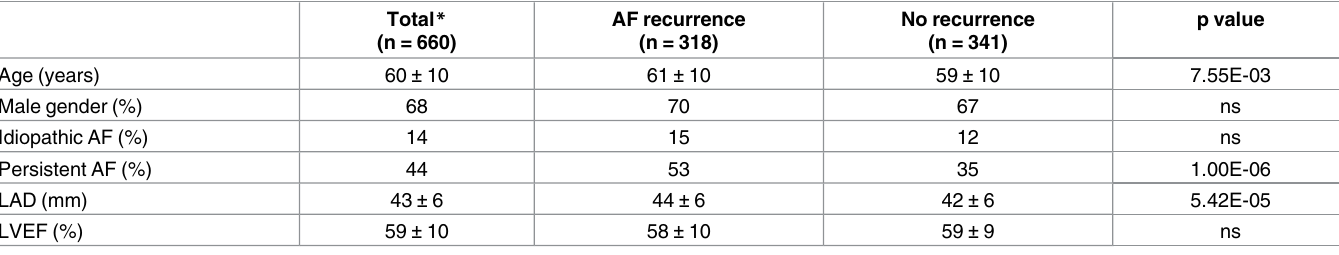
Table 1. Patient characteristics.